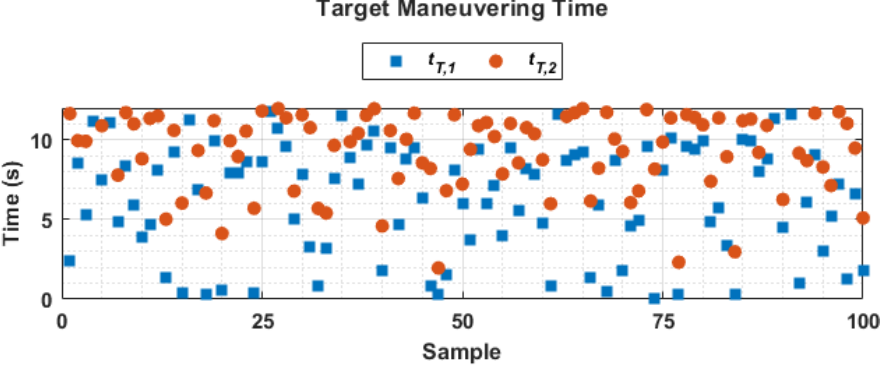
Figure 5. Target maneuvering time instants.